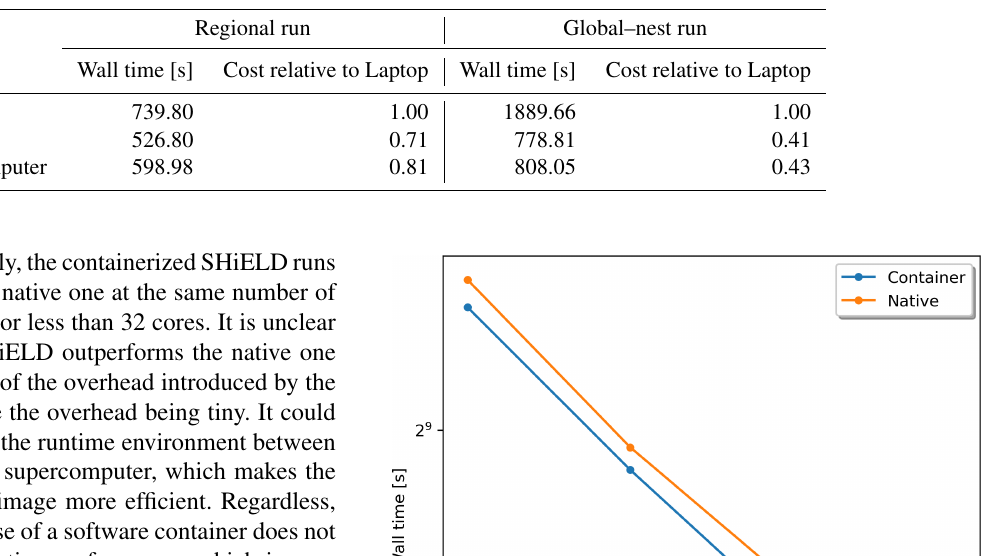
Table 3. Wall time of the regional and the global–nest run for a 24h simulation of Hurricane Laura on different machines. The regional run uses two MPI (message passing interface) processes and the global–nest run uses eight MPI processes. Docker is used on all machines except for the supercomputer, where Singularity is used.